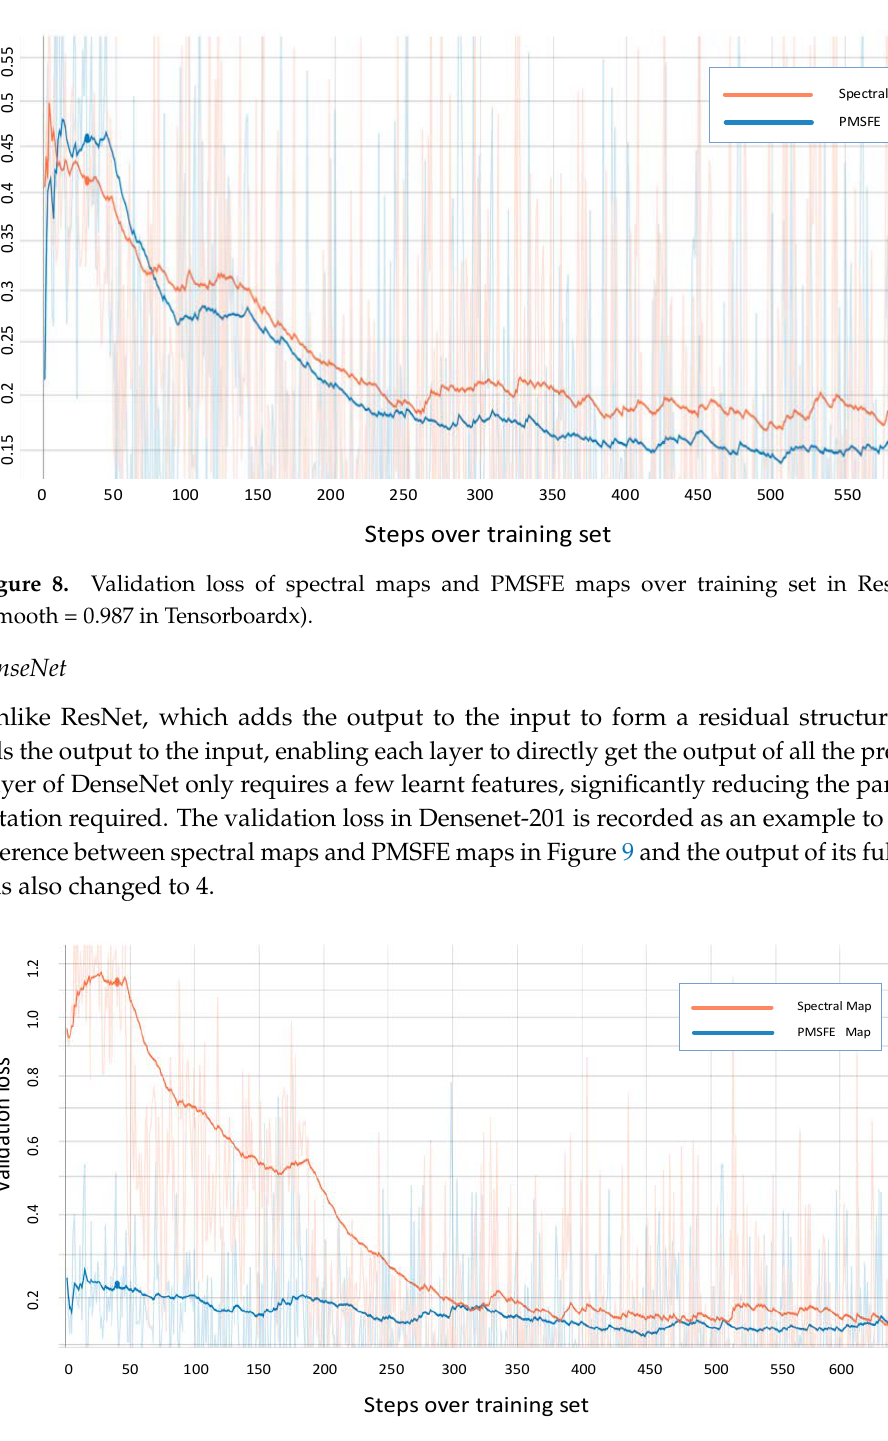
Figure 9. Validation loss of spectral maps and PMSFE maps over training set in DenseNet-201. (Smooth = 0.978 in Tensorboardx).